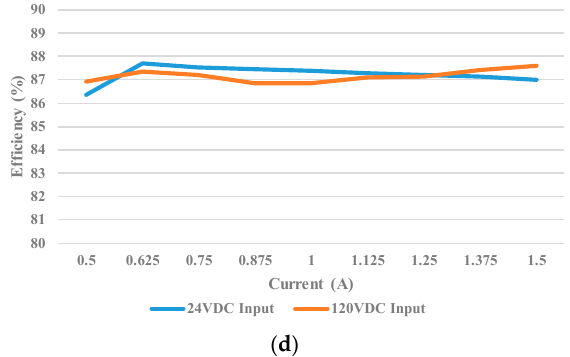
Figure 20. Measured efficiency in ( a )DCC, ( b )SCC, ( c )DCV and ( d )SCV regions.